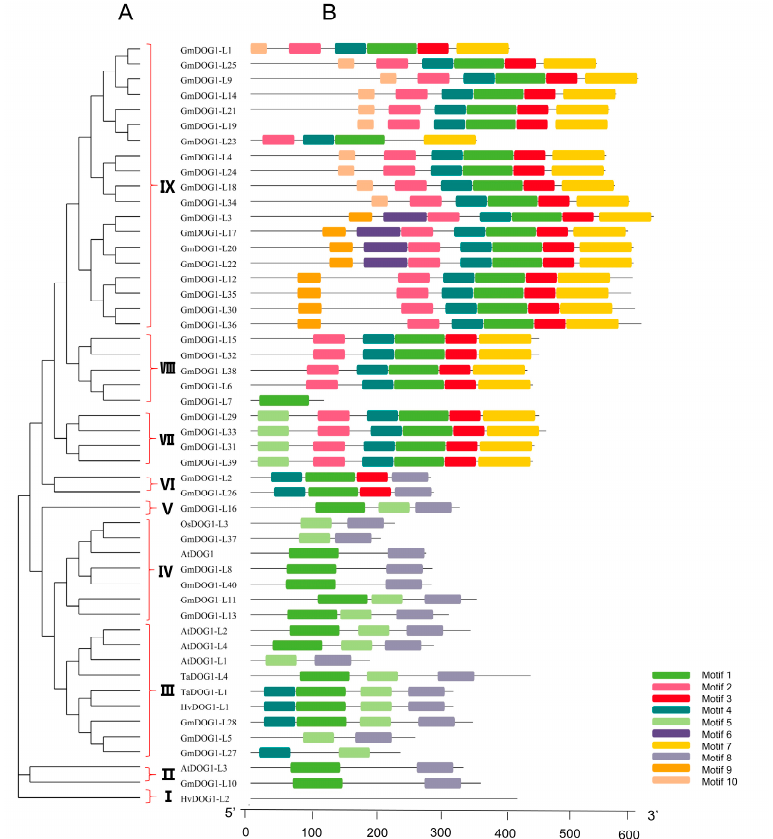
Figure 2. Phylogenetic analysis and conserved motifs of DOG1Ls. (A) The phylogenetic relationship of DOG1Ls. A maximum likelihood phylogenetic tree was constructed by MEGA7.0 software with the Poisson model and 1000 bootstrap replications. (B) Conserved motif arrangements of DOG1Ls. Ten conserved motifs labeled with different colors were found in the DOG1Ls sequences using the MEME program.